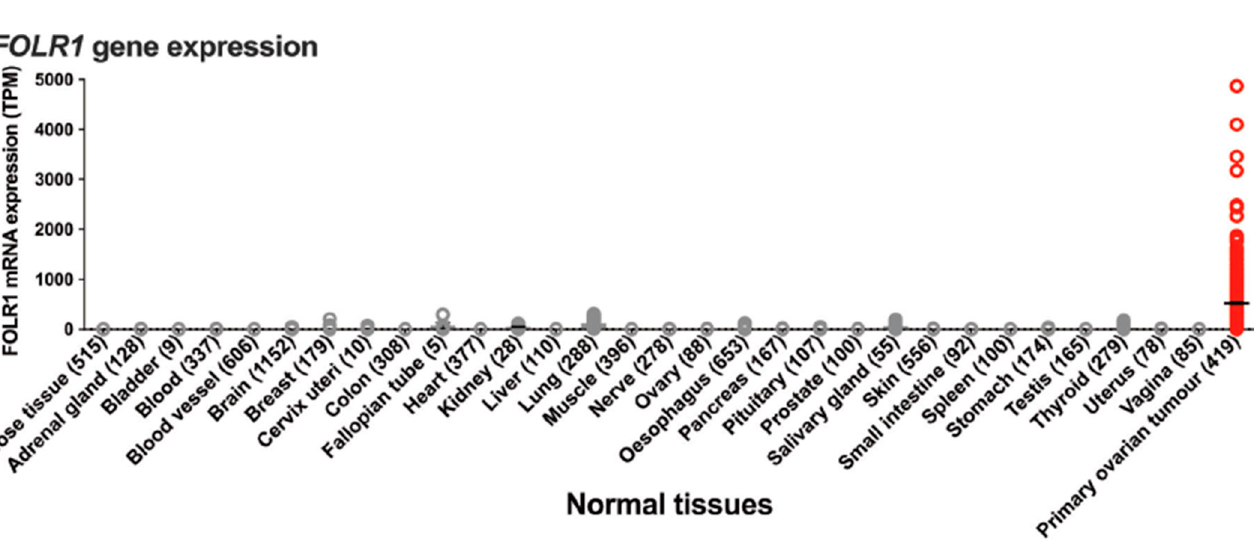
Gene-expression pro fi ling of FOLR1 across tumor samples and paired normal tissues (h tt p://gepia.cancer-pku.cn (accessed on17 February 2023) shows it to be preferentially ex- pressed in ovarian tumors (Figure 13).